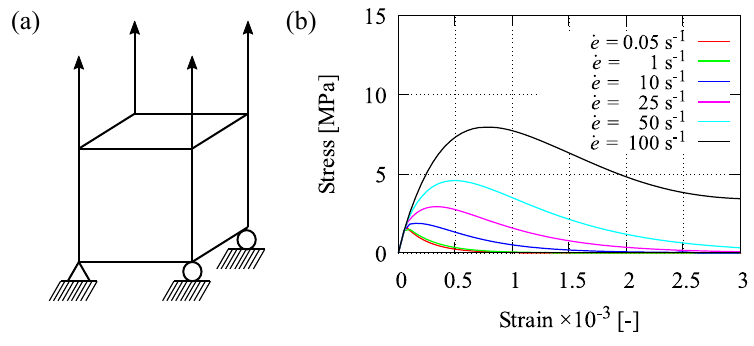
Figure 12. Homogeneous test: ( a ) illustration of uniaxial tension test and ( b ) strain rate effect.